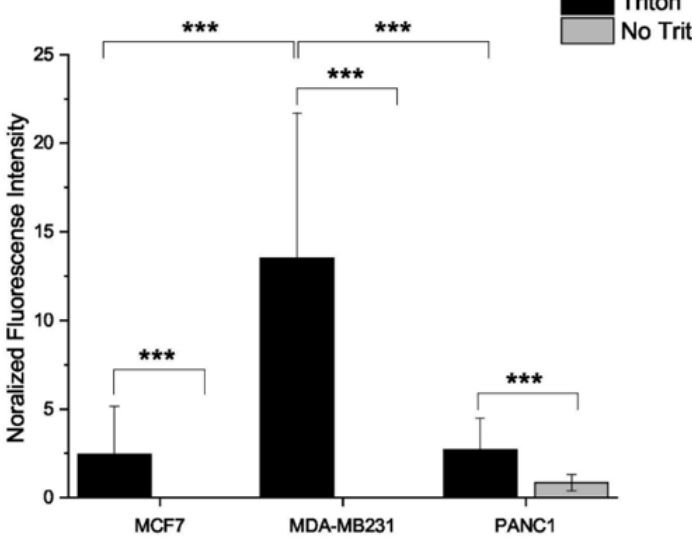
Figure 7. Quantification of the GPER1 expression. A total of 10 individual cells were chosen ( n = 10) from images with merged channels of the receptor signal and the signal of the nuclear staining. After color channel splitting, the image thresholds were adjusted until the disappearance of the background signal, and the signal intensity was quantified with the same threshold in every picture. After the subtraction of the mean background signal, the mean fluorescence intensity was normalized by the number of nuclei. Data are given as mean values ± standard deviation (SD). Asterisks mark the significant differences between groups ( p < 0.001: ***) determined by the One-way ANOVA test followed by Fisher’s LSD post hoc test.